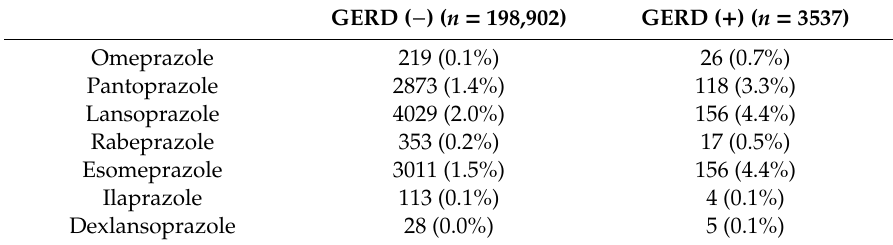
Table 3. Types of PPI according to presence and absence of GERD.